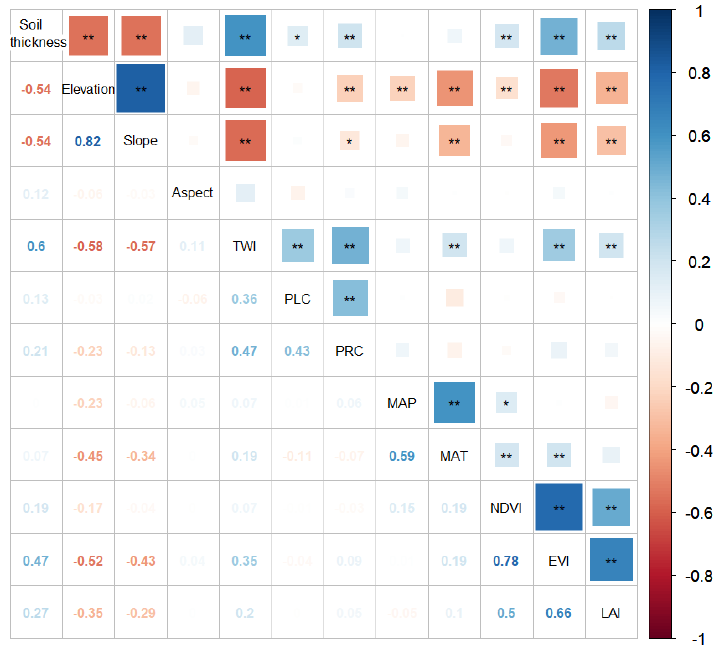
Figure 4. Pearson correlation coefficients between soil thickness and quantitative environmental variables used in this study. * and ** indicate significance levels at 0.05 and 0.01, respectively.